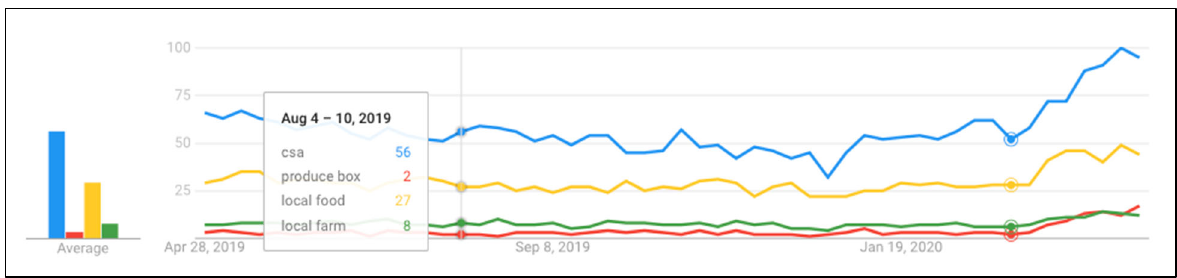
Source: Google Trends, April 27, 2020; circles to the right show week of March 1–7,